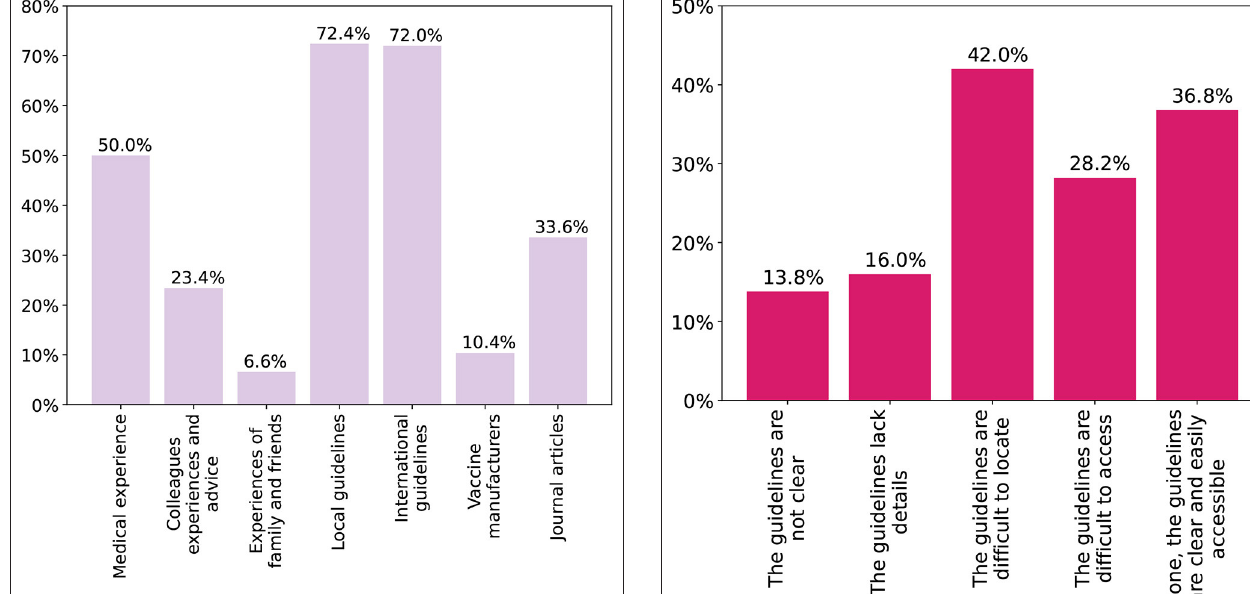
highest uptake rate being for influenza at 44.8% (23).